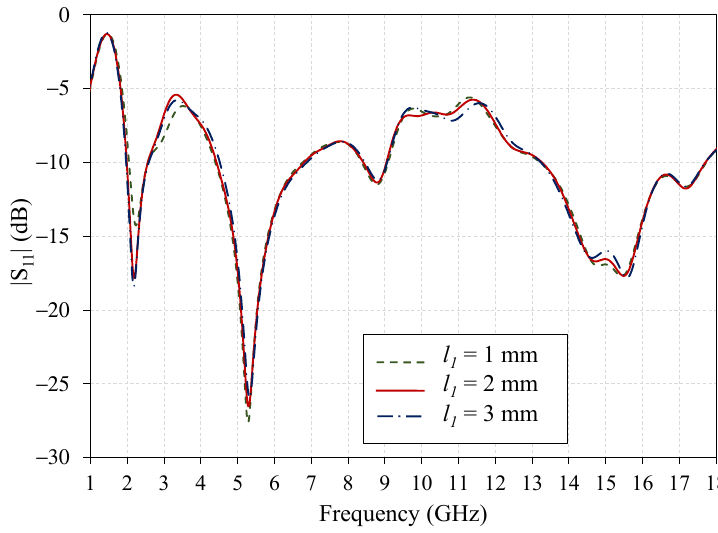
Figure 7. Simulated |S 11 | of the proposed antenna for various l 1 .